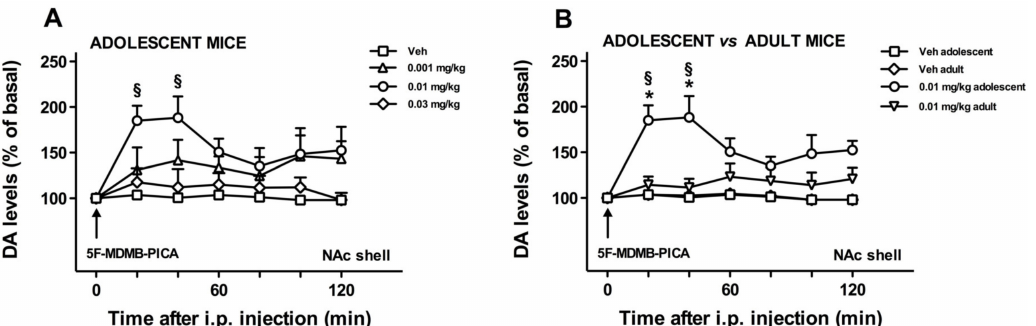
Figure 3. E ff ects of 5F-MDMB-PICA administration on DA transmission in the NAc shell of adolescent ( A , B ) and adult ( B ) mice. Results are demonstrated as mean ± SEM of the changes in DA extracellular levels expressed as the percentage of basal values. ( A ) The arrow indicates the i.p. injection of either Vehicle (squares) or 5F-MDMB-PICA, at the dose of 0.001 mg / kg (ascending triangles), 0.01 mg / kg (circles), 0.03 mg / kg (diamonds). §: p < 0.05 vs. basal values (One-way ANOVA; Tukey’s post hoc test). ( B ) The arrow indicates the i.p. injection of either Vehicle or 5F-MDMB-PICA: Vehicle-treated adolescent mice (squares), vehicle-treated adult mice (diamonds), adolescent mice treated with 5F-MDMB-PICA at a dose of 0.01 mg / kg (circles), adult mice treated with 5F-MDMB-PICA at a dose of 0.01 mg / kg (descendingtriangles), §: p < 0.05vs. basalvalues. * p < 0.05vs.